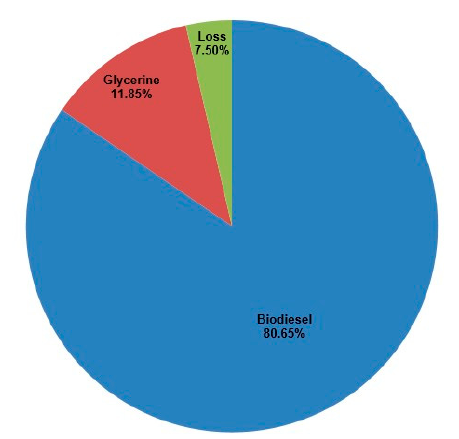
Figure 13. Energy balance for mandarin biodiesel conversion.